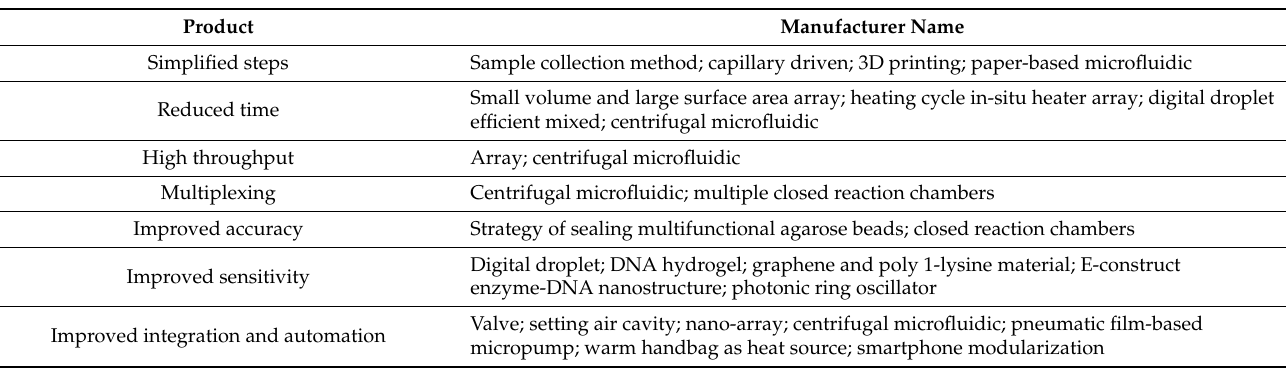
Table 3. Improvement in the microfluidic performance.